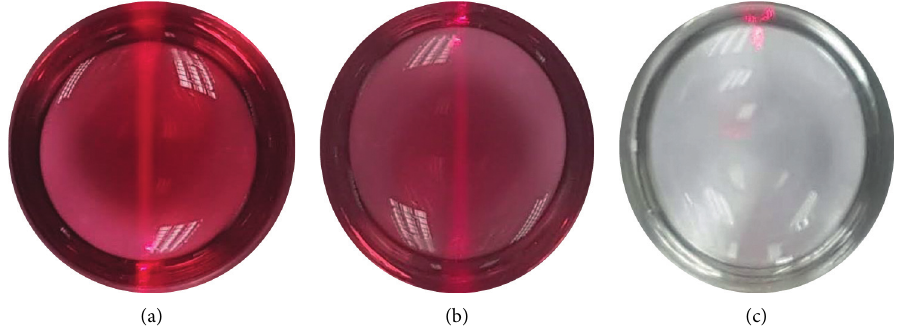
Figure 2: Surface plasmon resonance phenomenon test results for (a) Cit-HAuNPs and (b) Cit-MAuNPs and (c) MilliQ